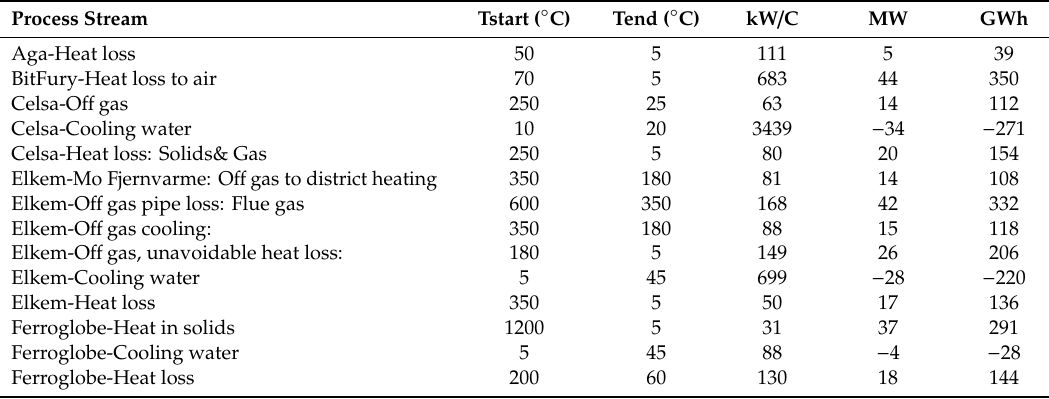
Table A1. Base case stream data as basis for Grand Composite curve in Figure